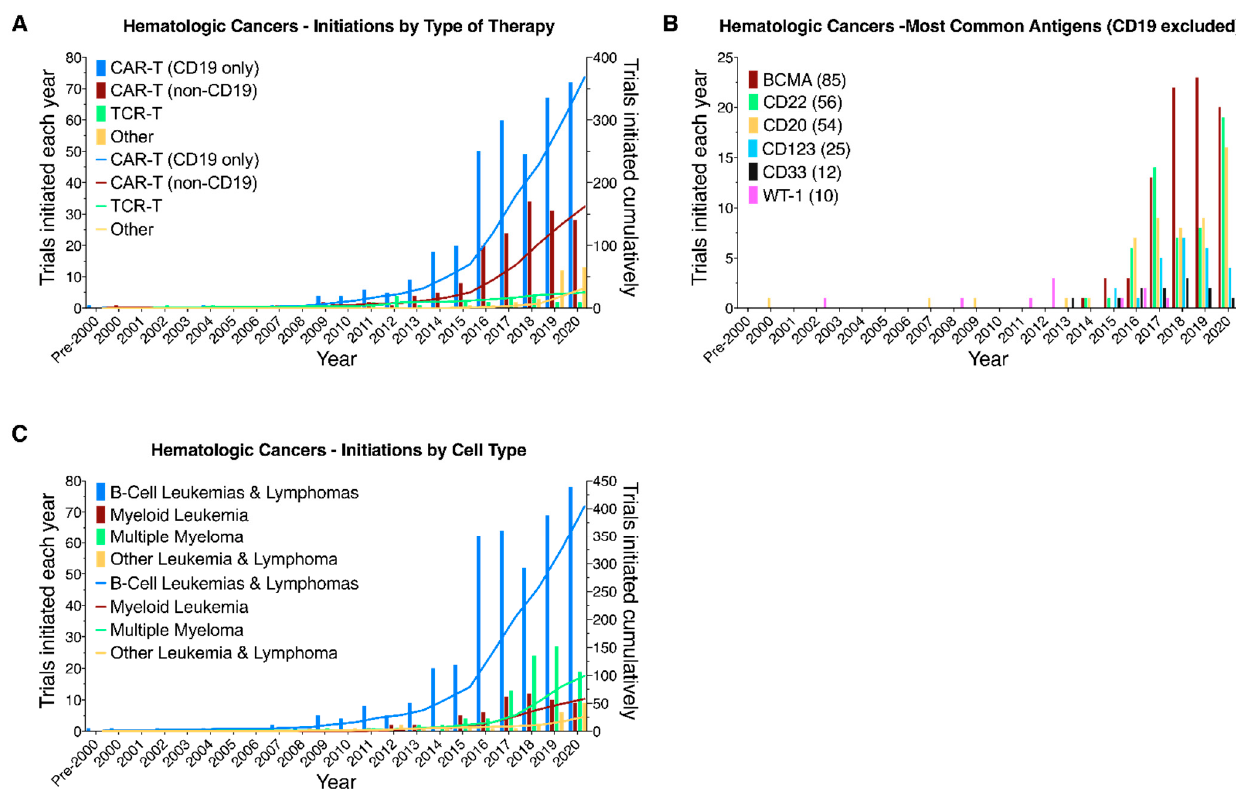
Figure 5. CAR-T/TCR-T clinical trials targeting hematologic cancers. Yearly (bars) and cumulative (lines) numbers of CAR-T/TCR-T trials registered on clinicaltrials.gov and initiated on or before 31 December 2020, targeting hematologic cancers. Trials were segmented by ( A ) type of therapy, ( B ) commonly targeted antigens, and ( C ) targeted cell